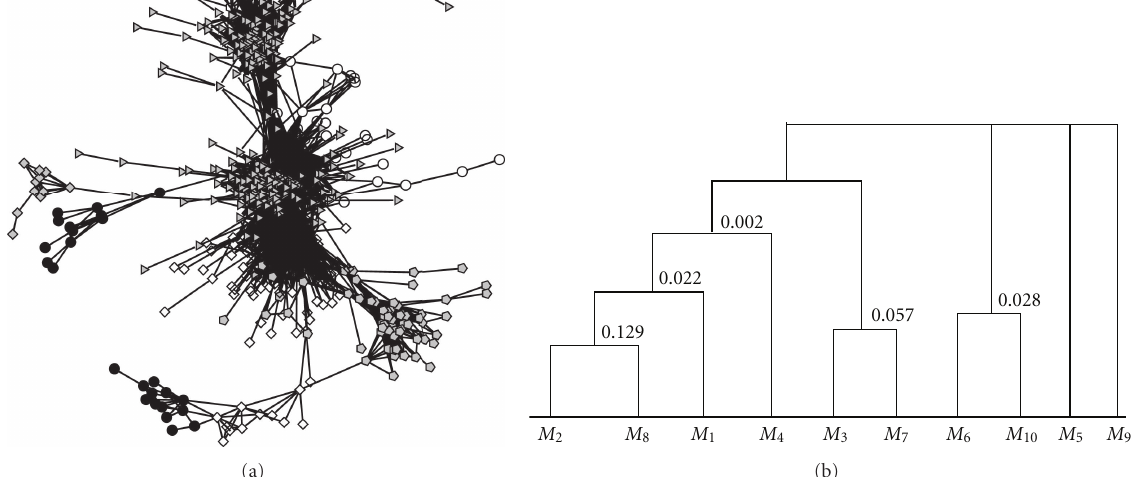
Figure 5: Yeast gene coexpression network. (a) The network structure, (b) the hierarchical